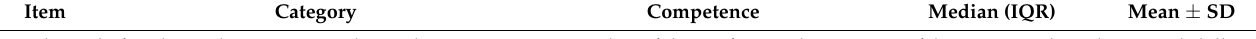
Table 1. Overview of all items asked in the individual categories in the field of anesthesiology (premedication visit und preparation of general anesthesia) and the average rating of the participants from 1 (“not relevant at all”) to 6 (“very relevant”) as median and IQR and mean value and